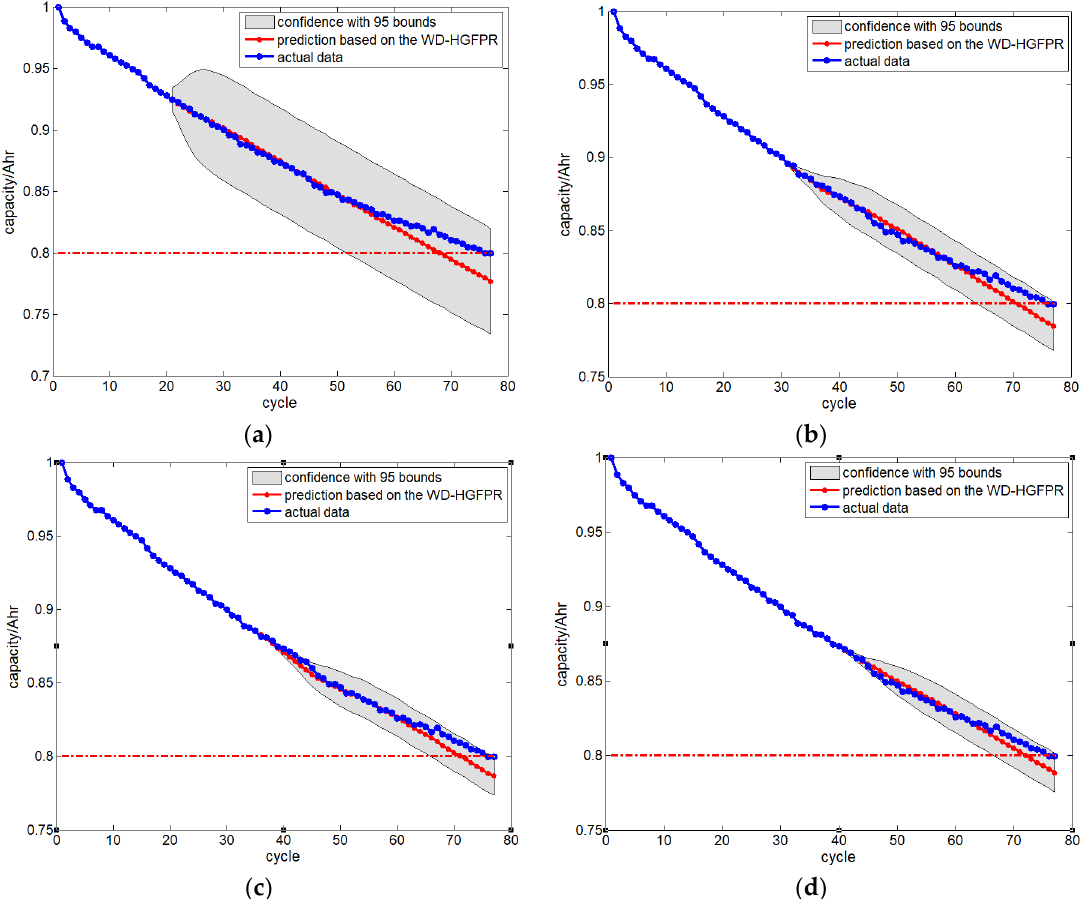
Figure 9. Prediction results using proposed method with different lengths of training data for Cell-7 battery. ( a ) RUL prediction results with 20 training data, ( b ) RUL prediction results with 30 training data, ( c ) RUL prediction results with 35 training data, and ( d ) RUL prediction results with 40 training data.